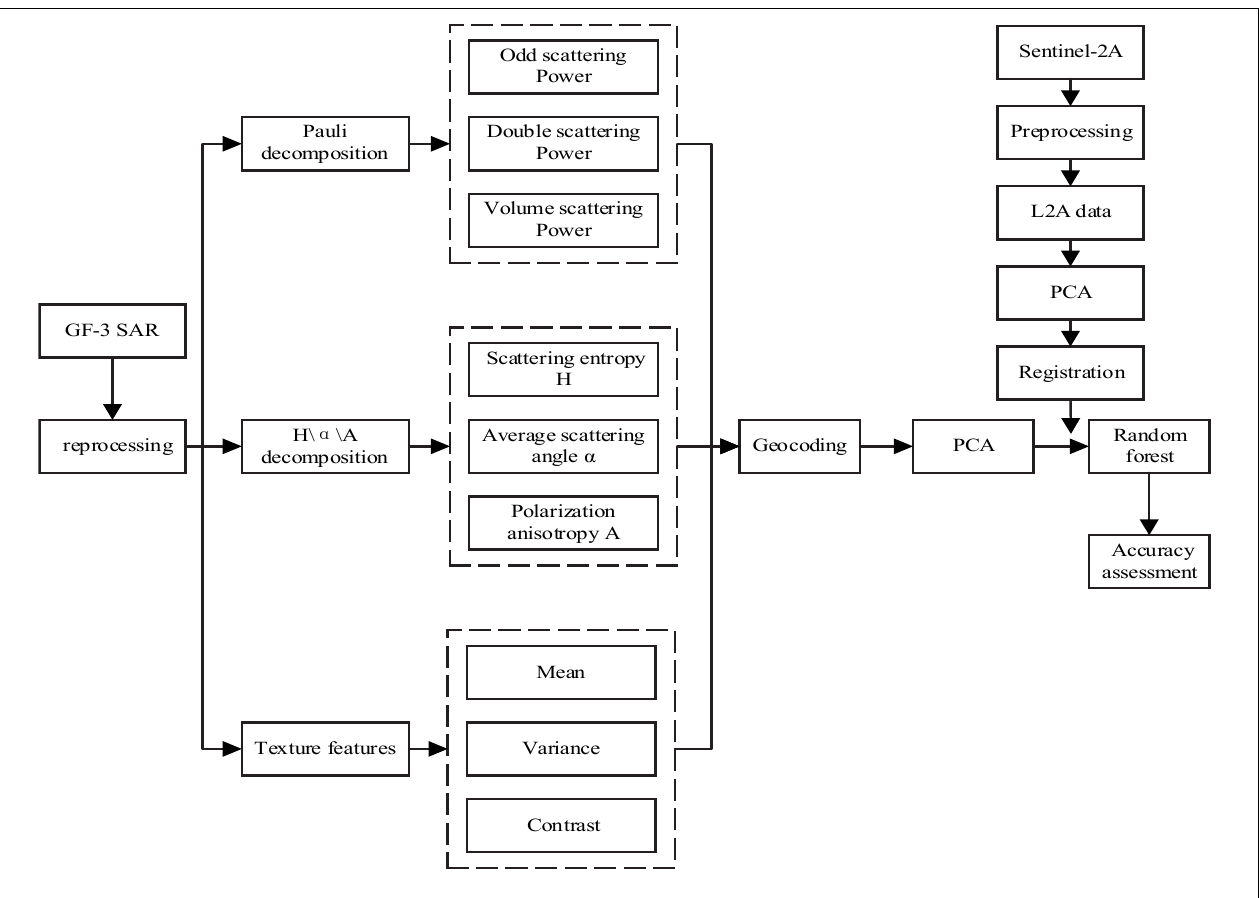
FIGURE 4 | Flow chart of the method for extracting the wetland objects.